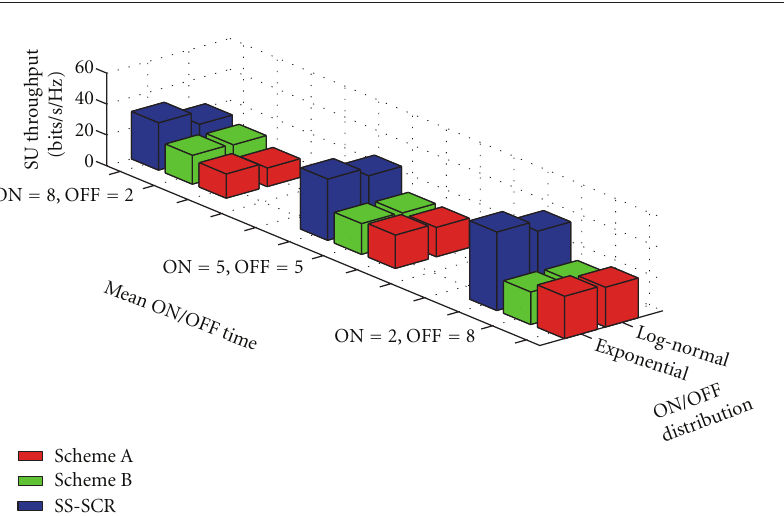
Figure 9: SU throughput versus mean ON/OFF time: log-normal and